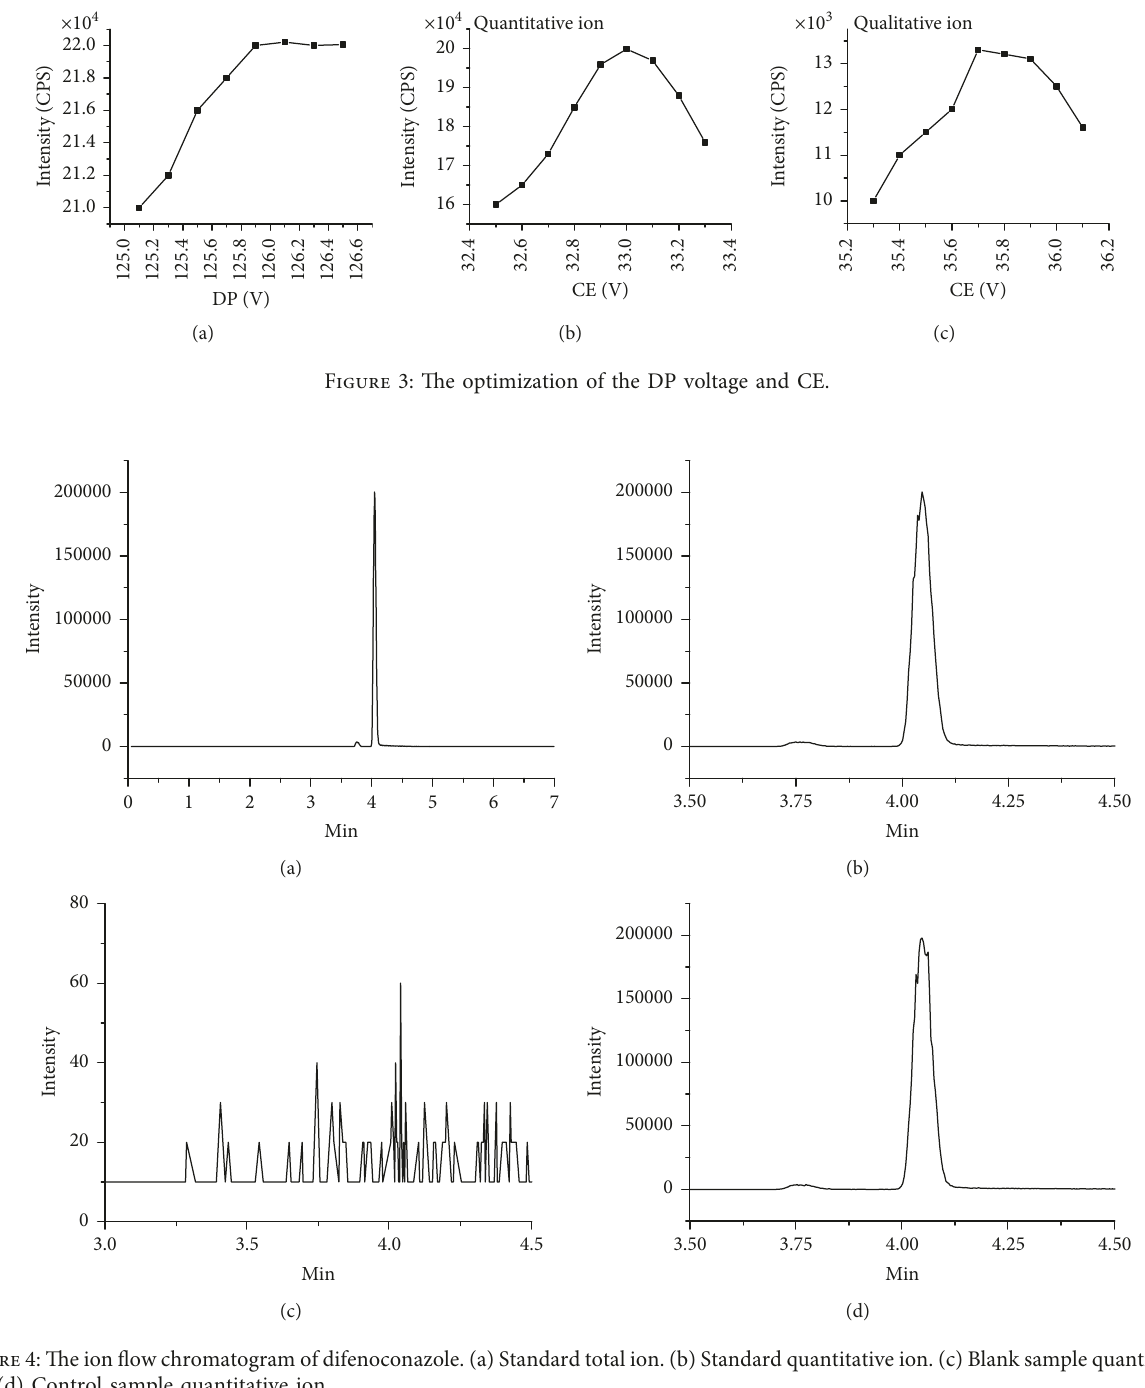
Figure 4: The ion flow chromatogram of difenoconazole. (a) Standard total ion. (b) Standard quantitative ion. (c) Blank sample quantitative ion. (d) Control sample quantitative ion.